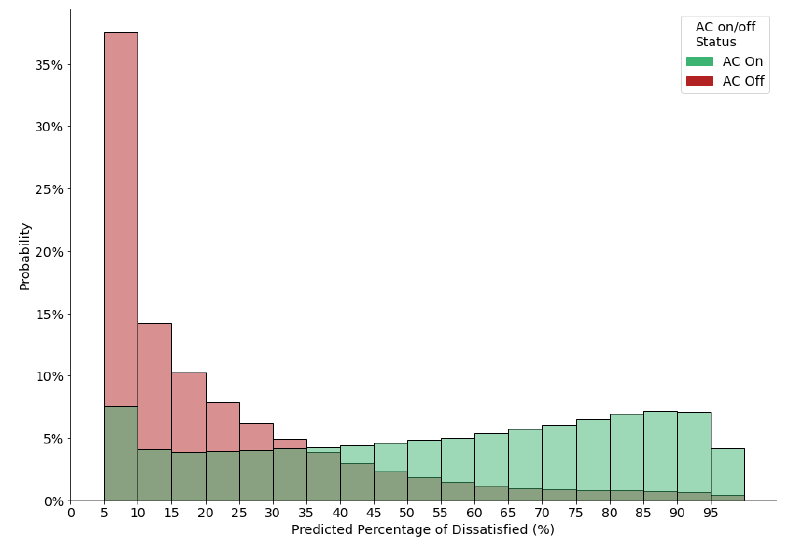
Figure 6. AC on/off probability at various PPD values from uncertainty analysis.